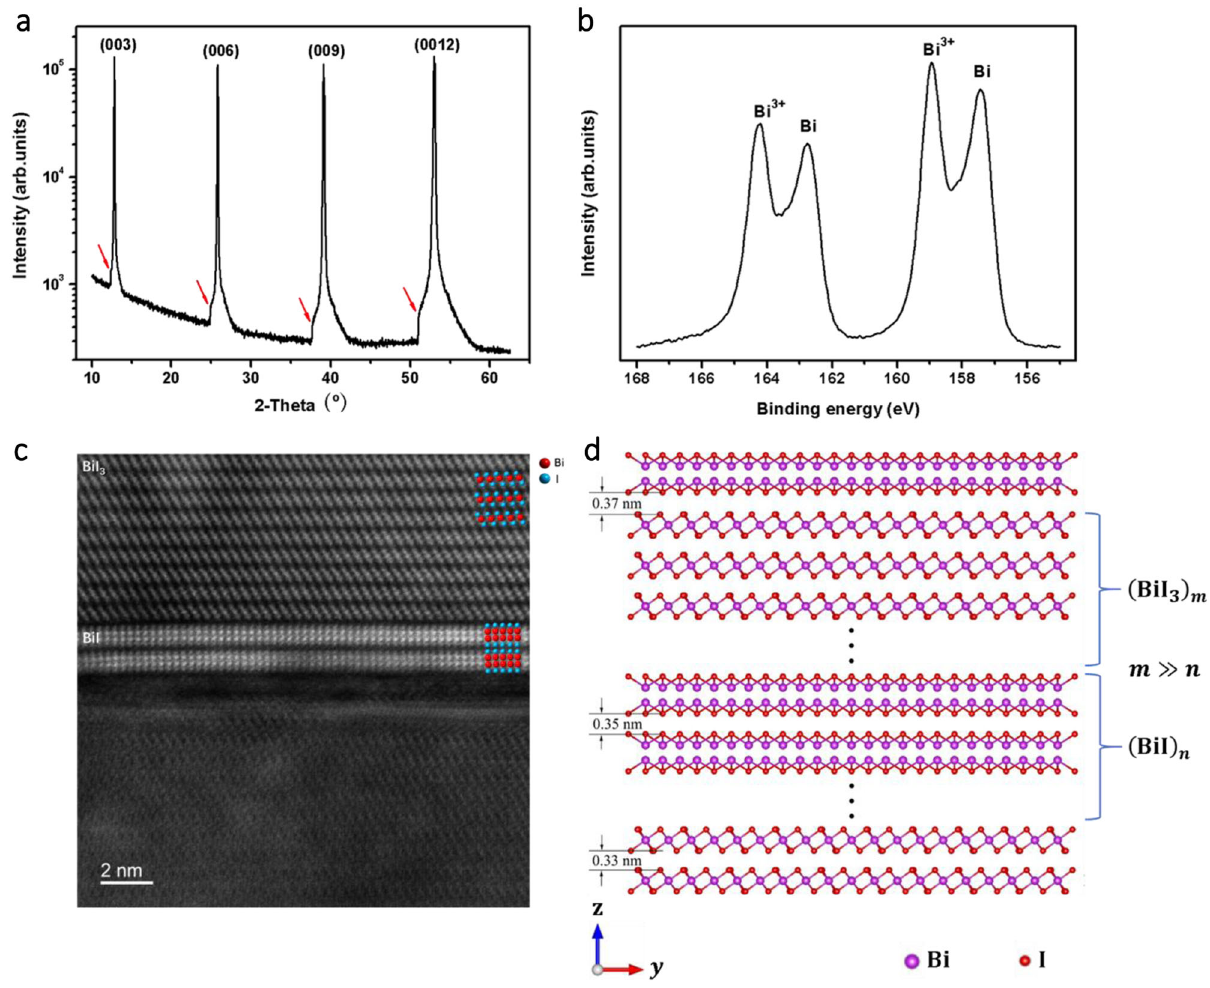
Fig.2|StructurecharacterizationofBi x I y .a (001)surfaceX-raydiffraction(XRD) pattern of Bi x I y , the red arrows point to a minor secondary diffraction of Bi x I y . b X-ray photoelectron spectroscopy (XPS) of Bi 4f for Bi x I y . c High-angle annular dark- fi eld scanning transmission electron microscope (HAADF-STEM) image